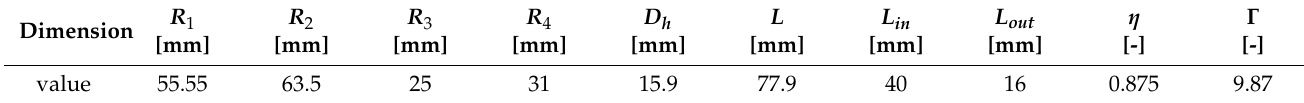
Table 5. Taylor numbers of considered flow cases from Lee [6].